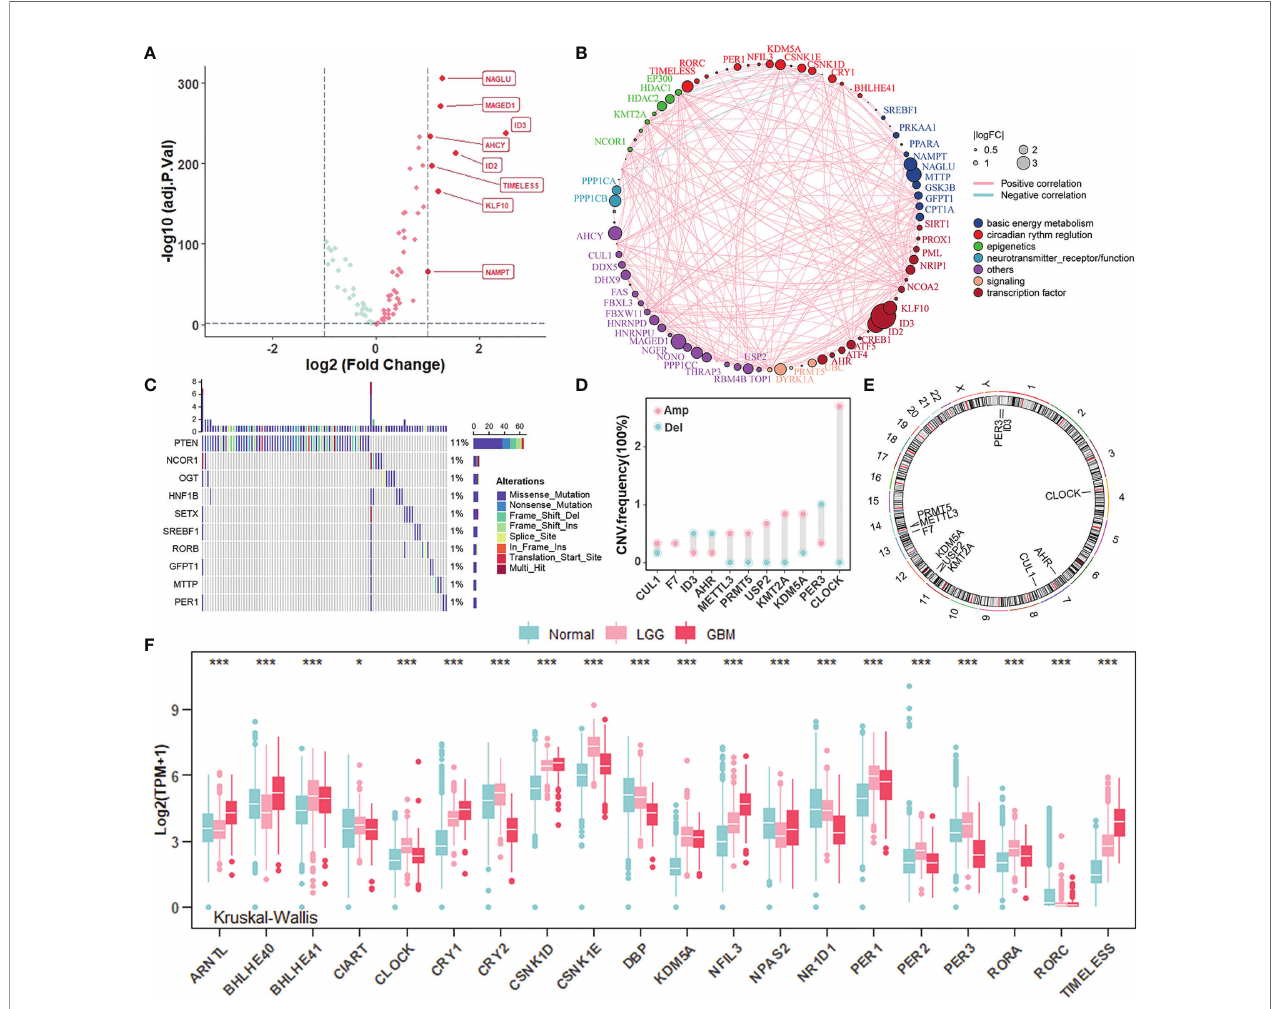
FIGURE 1 | Landscape of genomic variations and transcription pro fi le of circadian rhythm genes in gliomas. (A) Volcano plot of differentially expressed CR genes between normal and glioma (TCGA-LGGGBM: TCGA-LGG and TCGA-GBM) samples (Wilcoxon test: adjust p < 0.05, and |log2FC| > 1). The overexpressed genes in gliomas were highlighted in red. (B) The interaction between CR genes in gliomas. The CR genes with different features were depicted by circles in different colors. The lines connecting CR genes represented their interaction with each other. The size of each circle represented the differential expression of CR genes in gliomas compared to normal. (C) The mutation frequency of CR genes in 584 patients from the TCGA cohort. Each column represented an individual patient. The upper bar plot indicated mutation-accumulation. The bar plot on the right indicated the proportion of each variant type with the number above representing mutation frequency. Only top 10 mutations were included. (D) The CNV frequency of CR genes in glioma patients from the TCGA cohort. The height of each column represented the alteration frequency. The ampli fi cation frequency, pink dot; The deletion frequency, blue dot. (E) The location of CR genes with CNV alteration on chromosomes. (F) The mRNA expression level of core CR genes among normal, TCGA-LGG, and TCGA-GBM samples. Normal, blue; LGG, pink; GBM, red. The asterisks represented the statistical p -value (Kruskal – Wallis test: * p < 0.05; *** p <